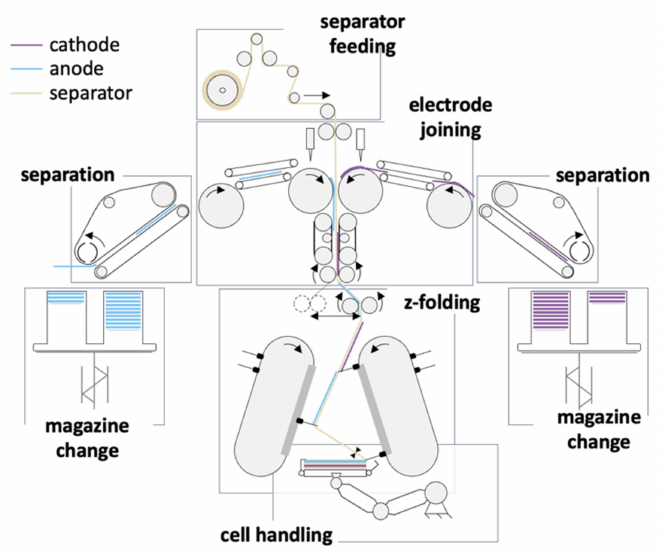
Figure 13. Architecture of the ESC assembly process in the research project KontiBat